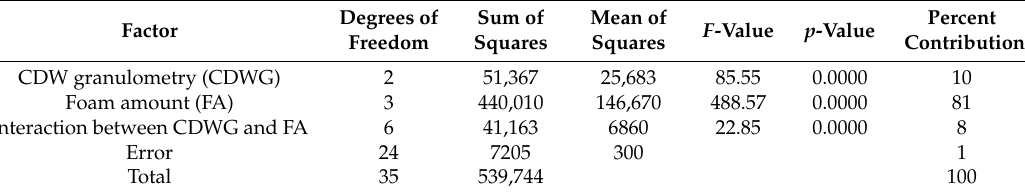
Table 4. Dry bulk density (DBD) ANOVA.